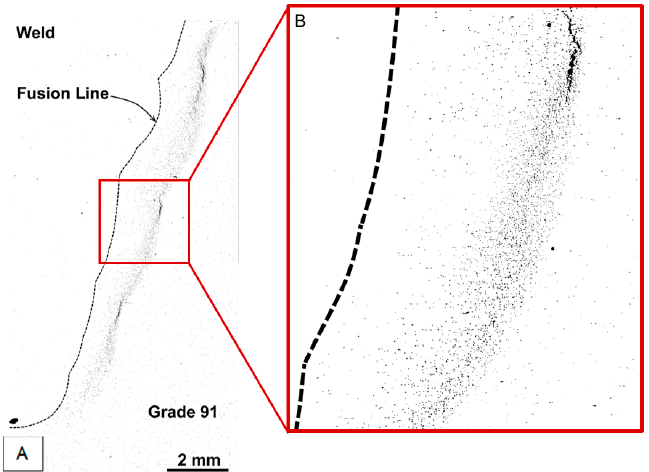
Figure 10. ( A ) Macro Image from the Examined Grade 91 Weldment and Highlighted Region of Interest along the fusion line and HAZ of the Weld; ( B ) Magnified View of Creep Damage in the HAZ of the Weldment.